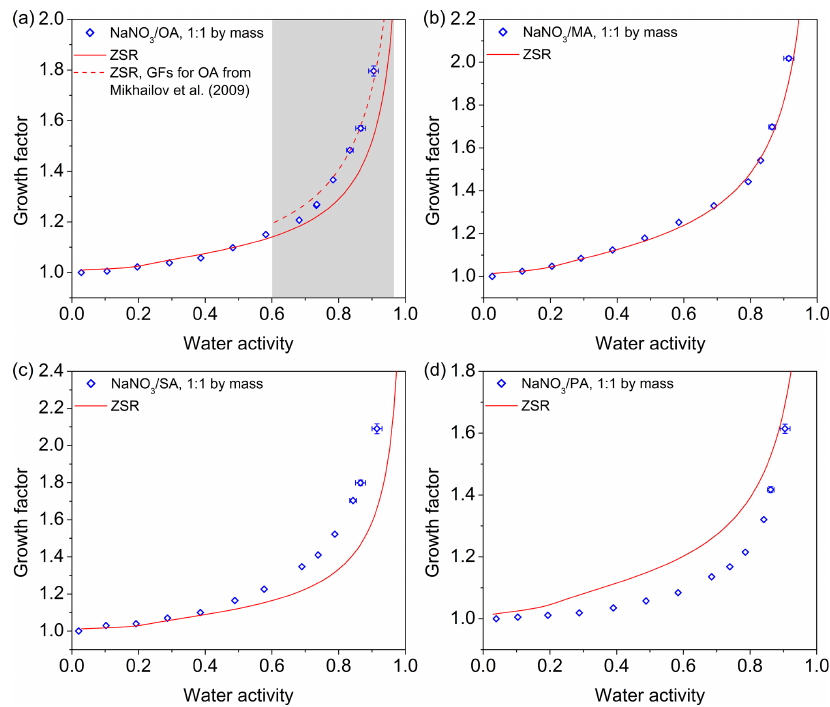
Figure 4. Hygroscopic growth factors of 100nm internally mixed particles composed of NaNO 3 / oxalic acid (OA) (a) , NaNO 3 / malonic acid (MA) (b) , NaNO 3 /succinic acid (SA) (c) and NaNO 3 / phthalic acid (PA) (d) with equal mass ratios as a function of water activity. The red line indicates the hygroscopic growth predicted from the ZSR method. For the NaNO 3 / oxalic acid (OA) mixture, the ZSR-predicted curve based on the GFs for OA from Mikhailov et al. (2009) is presented by the dashed line. The shaded area shows potential water uptake by the oxalic acid component. The error bars representing the standard deviation of multiple measurements are not obvious compared to the size of the symbols.